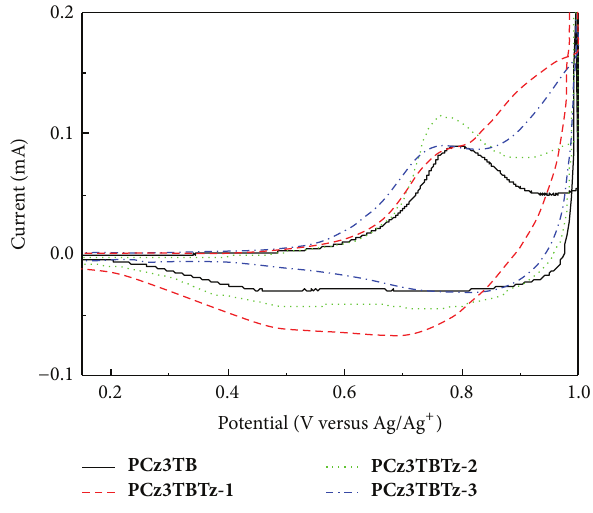
Figure 3: CV of the polymer films.